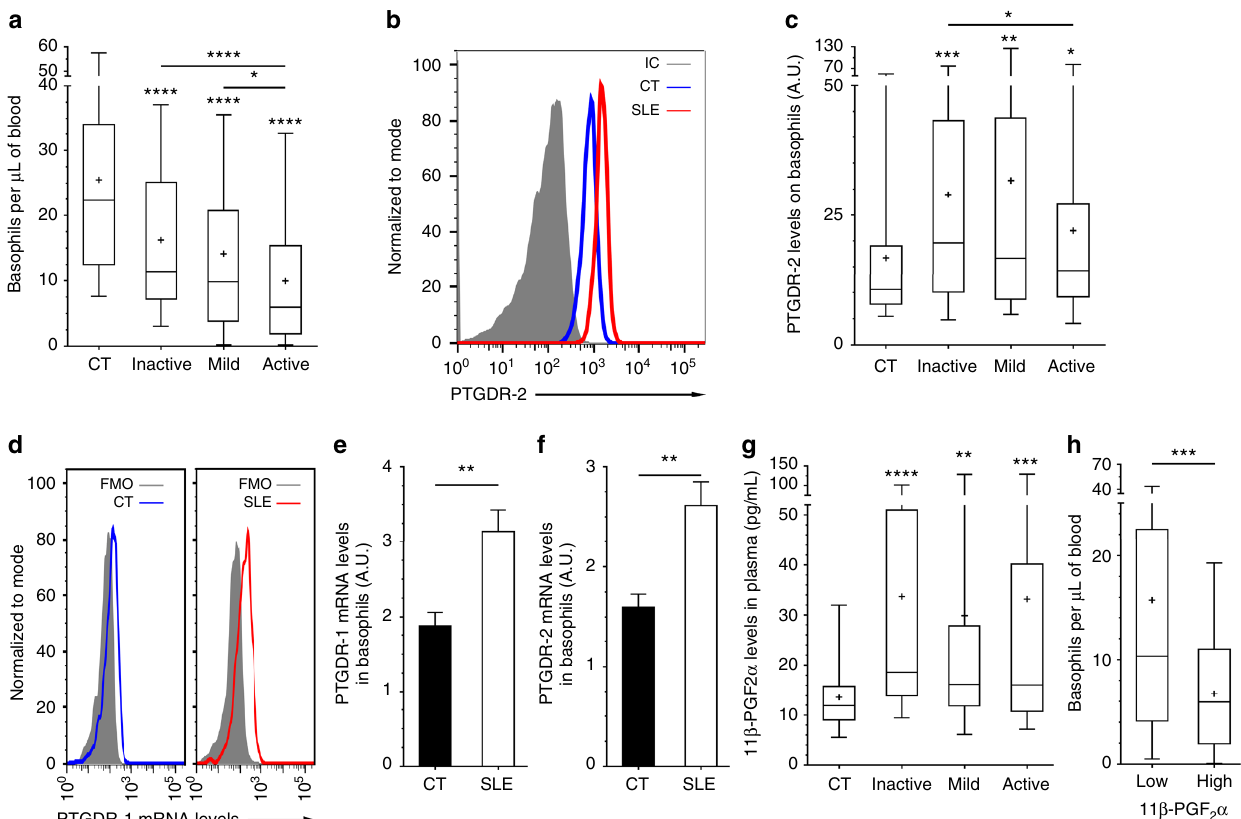
Fig. 1 PGD 2 -PTGDR axis is associated with basopenia in SLE. a Basophils per µ L of blood from CT and inactive, mild or active SLE patients ( n = 116/55/42/ 103, respectively) as determined by FACS as described in Supplementary Fig. 1. b Representative FACS analysis of PTGDR-2 expression on blood basophils from a healthy control (CT), a patient with active SLE and isotype control (IC) staining. c PTGDR-2 levels on blood basophils from patients as in ( a ) ( n = 101/49/34/78, respectively). d Representative FACS histograms of PrimeFlow TM RNA Assay showing PTGDR-1 RNA transcript expression by basophils from CT and active SLE individual compared to fl uorescence minus one (FMO). e , f PTGDR-1 ( e ) and PTGDR-2 ( f ) RNA transcript expressions in basophils from CT ( n = 6) and active SLE patients ( n = 7) (ratio MFI/FMO) as in ( d ). g 11 β -prostaglandin F 2 α (11 β -PGF 2 α ) levels in plasma from patients as in ( a ) ( n = 44/33/28/66, respectively). h Basophils per µ L of blood in patients with SLE grouped by low ( n = 84) or high ( n = 39) 11 β -PGF levels above CT mean + 2 standard deviations). a , c , e – h Data are presented as median and interquartile ranges with whiskers representing 5 – 95 percentiles and the mean presented as a “ + ” symbol. Statistical analyses were by Mann − Whitney tests. e , f Data are presented as mean ± s.e.m. Statistical analyses were by unpaired Student t tests. a , c , e – h NS: not signi fi cant, * P < 0.05, ** P < 0.01, *** P < 0.001, **** P < 0.0001. Comparison to control group is shown above each bar and to the corresponding bars when indicated. A.U. arbitrary